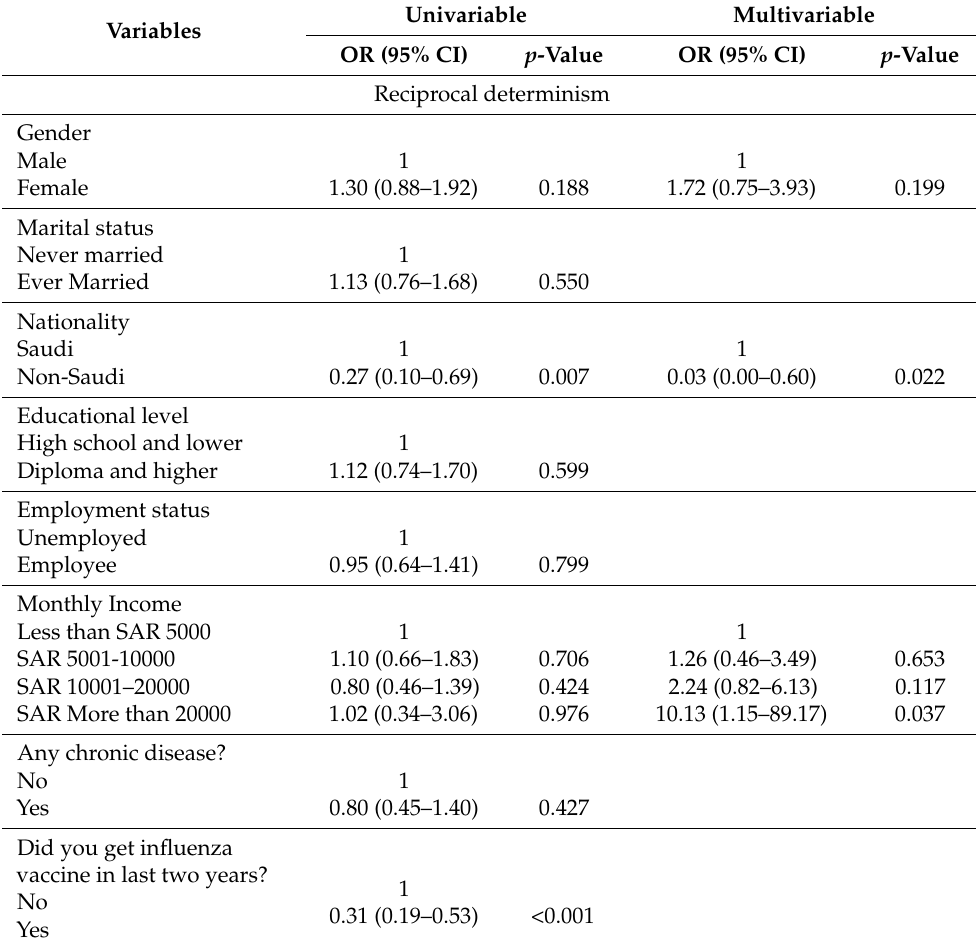
Table 3. Association of vaccine rejection with various constructs of social cognitive theory in Qassim, Saudi